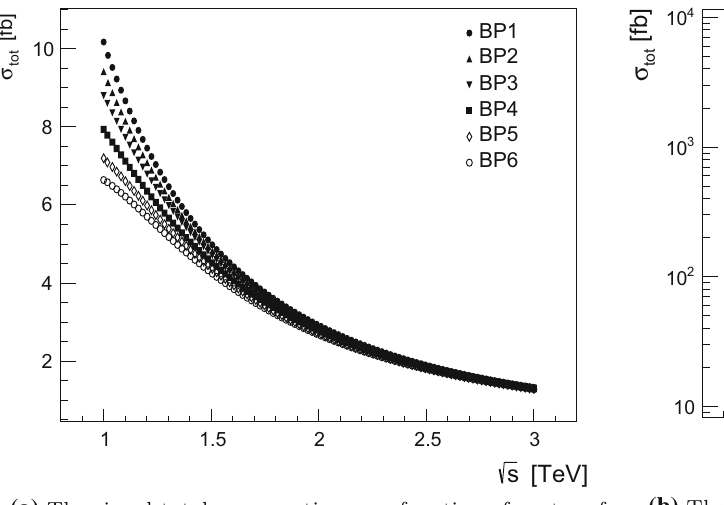
center of mass energy.